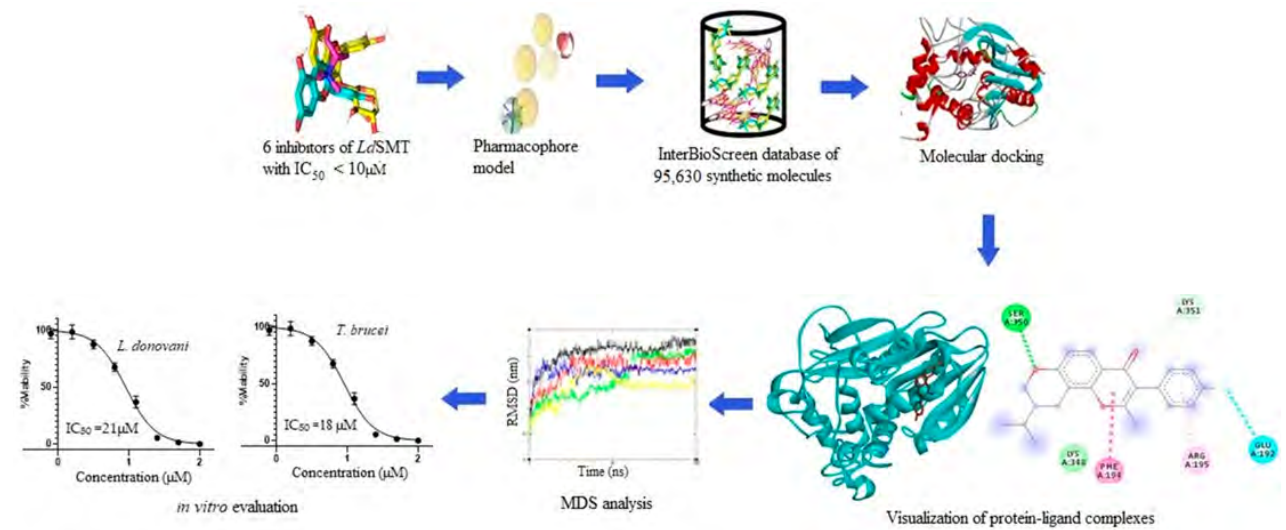
Figure 2. Methodology schema employed in the identification of antileishmanial compounds target- ing Ld SMT. The workflow details the pharmacophore-based virtual screening, molecular docking, and MD simulation as well as in vitro validation of the selected potential antileishmanial and anti- trypanosomal